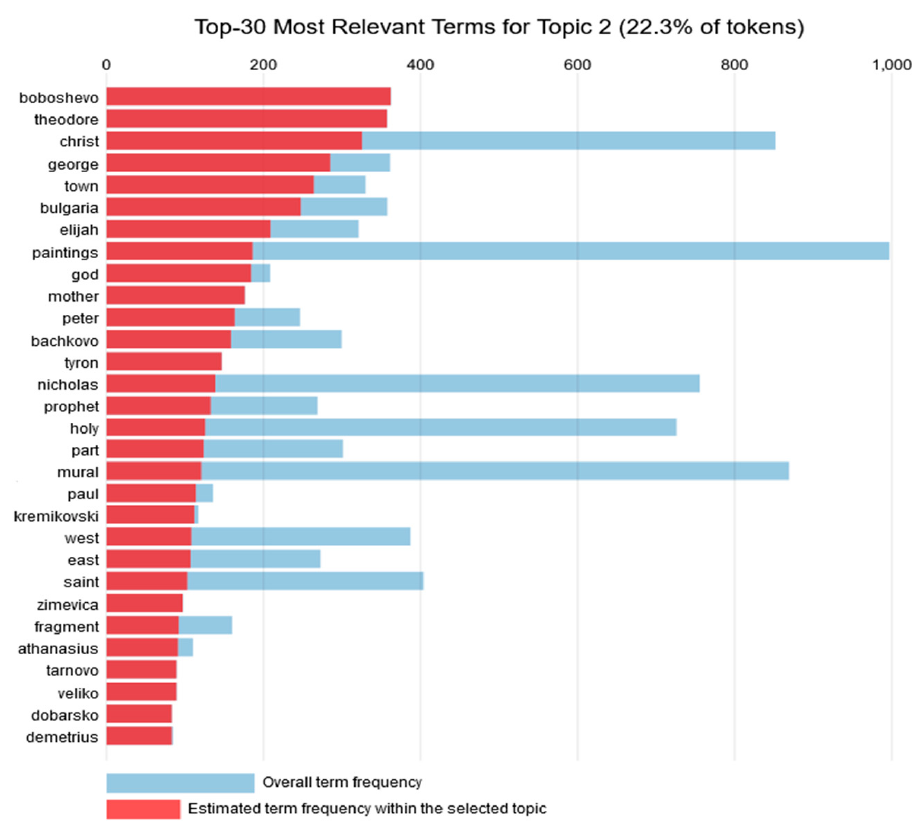
Figure 3. Top-30 most relevant terms for Topic 2.